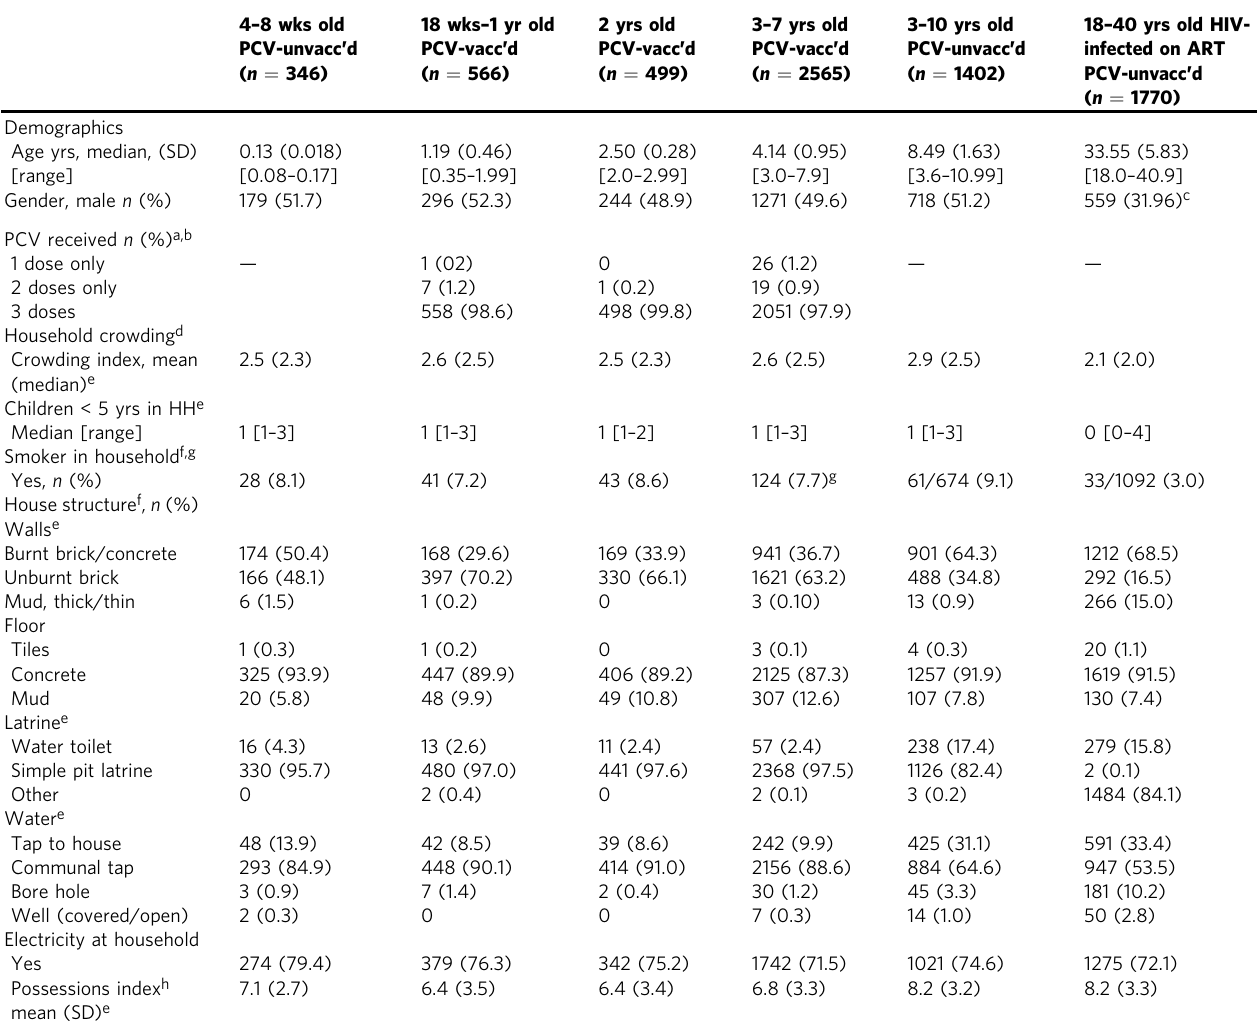
Table 1 Demographic and household characteristics of study